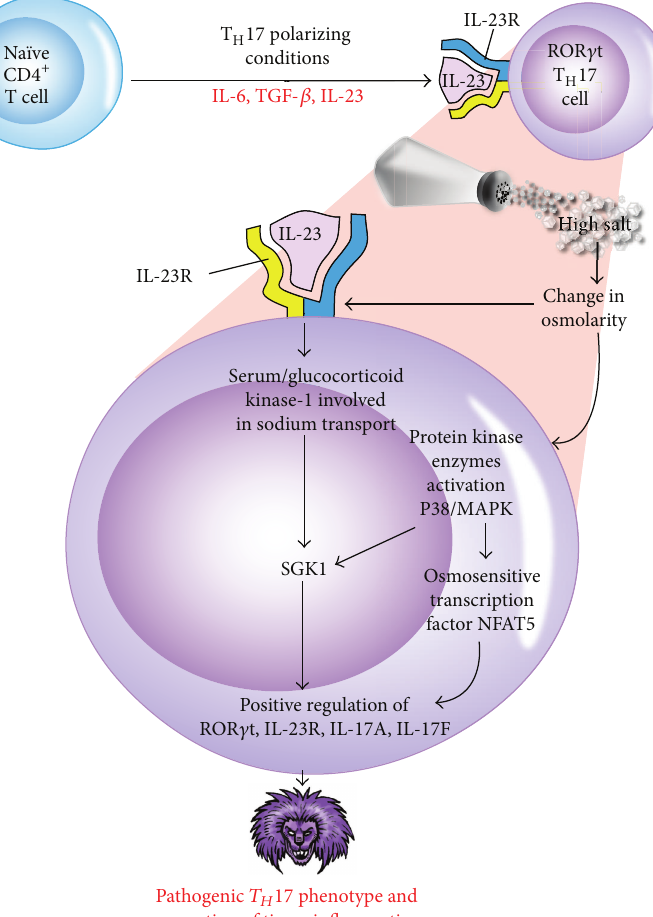
Figure 11: Mechanism by which a high-salt diet enhances the differentiation of na¨ıve CD4 + cells to pathogenic T H 17 cells that may exacerbate experimental autoimmune encephalitis. High salt concentration, change in osmolarity, the influence of IL-23 and IL-23 receptor signaling, and the activation of various enzymes drive the expression of T H 17-associated cytokines and the formation of pathogenic T H 17